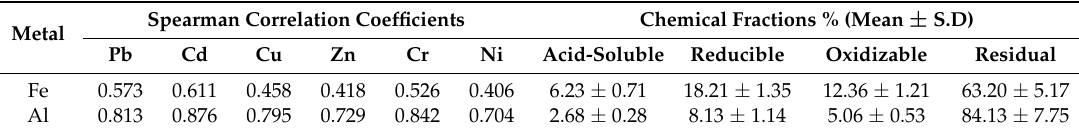
Table 2. Spearman correlation coefficients of Fe, Al, and their chemical fractions in the subsoil ( n =